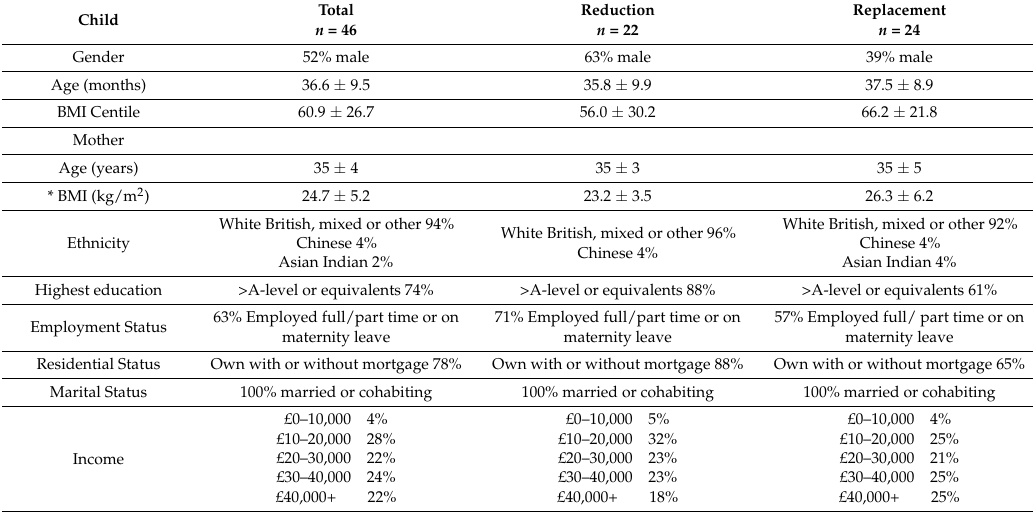
Table 2. Demographic information for mother-child dyads (mean ±